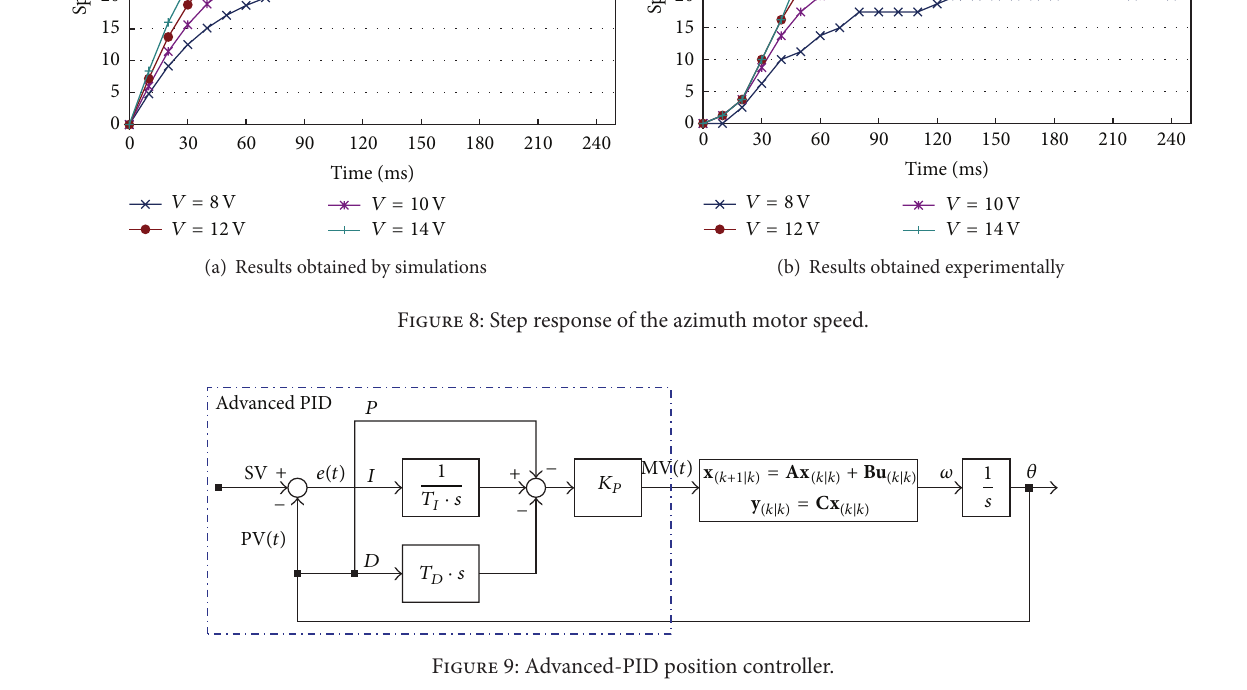
Figure 9: Advanced-PID position